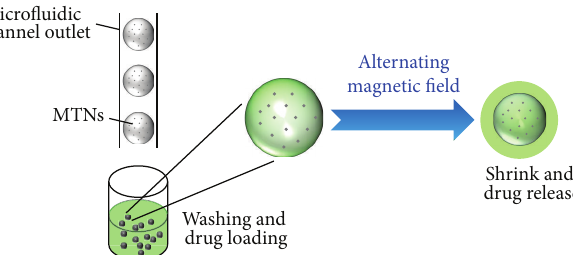
Figure 1: Principle of magnetically controlled drug release using PNIPAM microparticles with embedded iron oxide nanobeads (NBs) to form monodispersed magneto-thermoresponsive nanocomposites (MTNs). The MTNs are fabricated in a microfluidic system and filled with a drug by means of diffusion. The heat generated by the NBs upon the application of an alternating magnetic field causes the gel-structure to shrink and the release of drug.